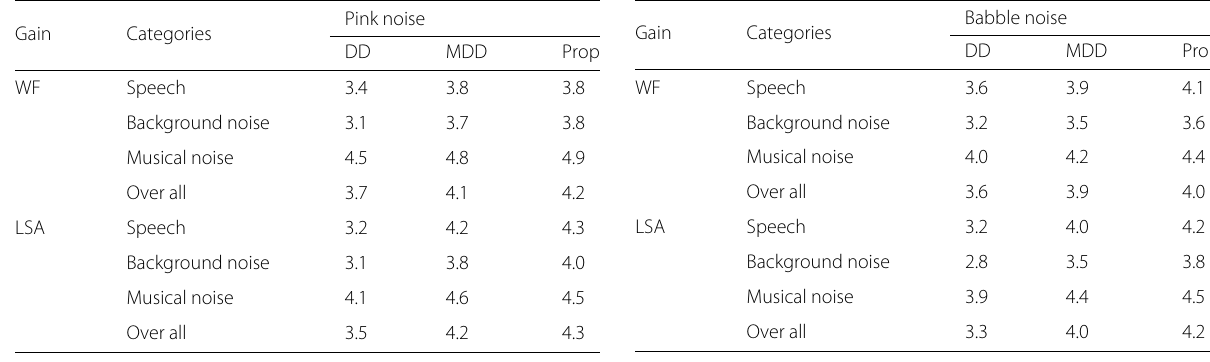
Bold values denote the best performance